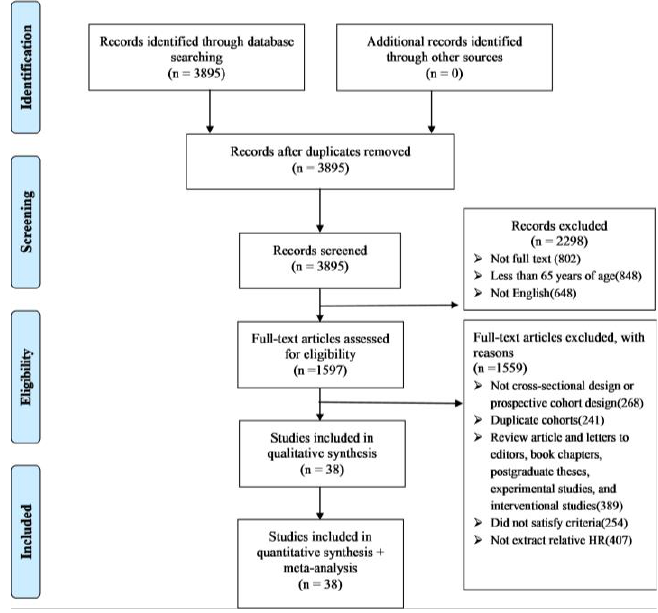
Figure 1. Research flowchart.